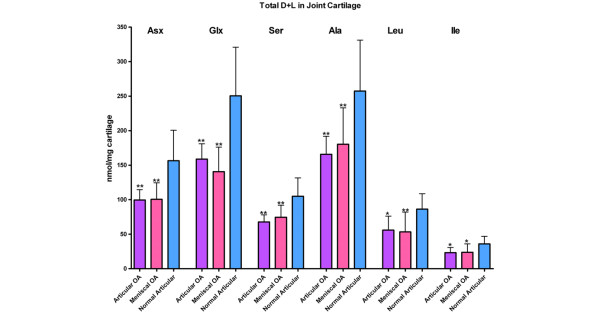
Differences in mean total amino acids D+L (nmol/mg + standard deviation) between normal articular cartilage (n = 12 age-matched samples), paired osteoarthritic (OA) articular cartilages (n = 30), and OA meniscal cartilages (n = 30). The normal tissue was age-matched to the OA tissues. Analysis of variance results were P < 0.0001 for asparagine + aspartate (Asx), glutamate + glutamine (Glx), serine (Ser), and alanine (Ala); P < 0.0005 for leucine (Leu); and P = 0.0012 for isoleucine (Ile). Significance of change from normal cartilage by Bonferroni post test was *P < 0.01 and **P < 0.001. Light blue represents normal articular cartilage, purple represents OA articular cartilage, and pink represents OA meniscal cartilage.